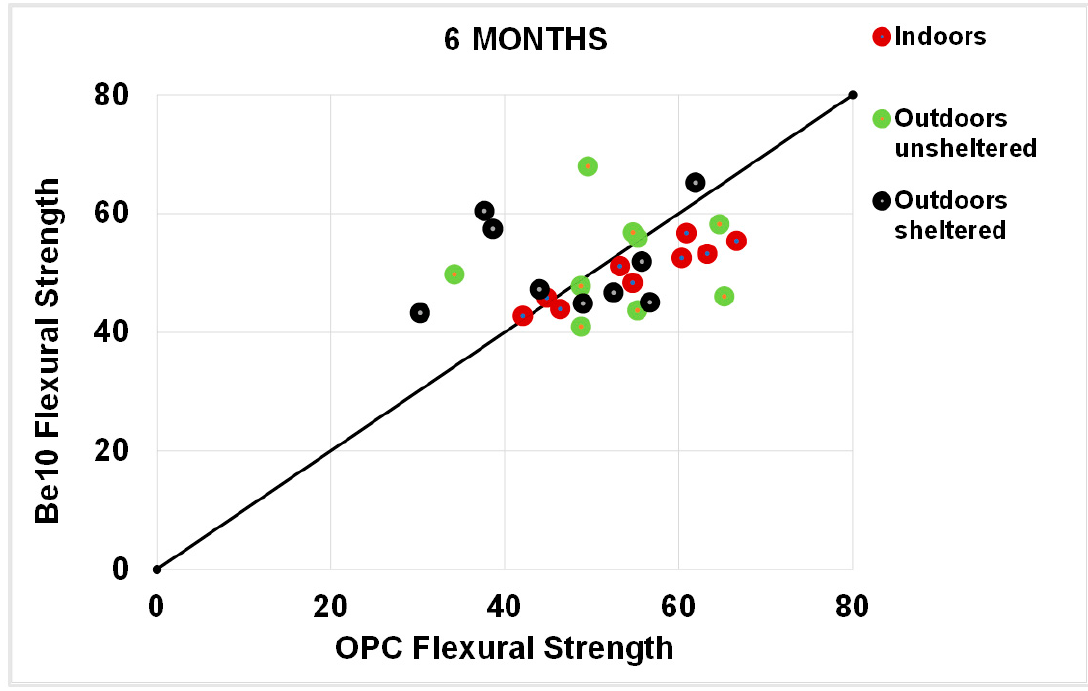
Figure 15. Six-month flexural strength: OPC vs. Be10.